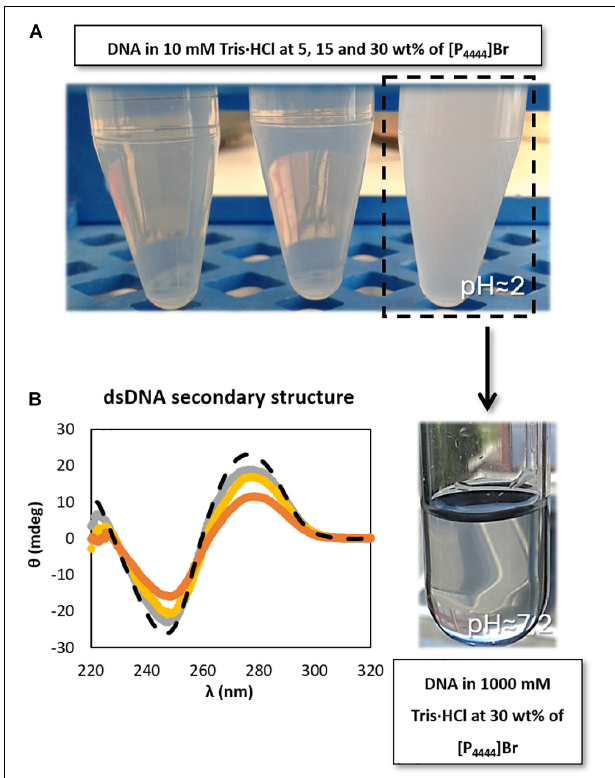
FIGURE 4 | Schematic representation of (A) DNA dissolution process with the increase of buffer concentration (increase of pH value) and (B) CD spectra regarding the ellipticity, θ , of 0.01 g dm − 3 of β -DNA (from salmon testes) as a function of wavelength, λ , in 1000 mM Tris–HCl buffer (pH ≈ 7.2). ( — ) only buffer; ( • ) 5 wt% of [P 4444 ]Br; ( • ) 15 wt% of [P 4444 ]Br; ( • ) 30 wt% of [P 4444